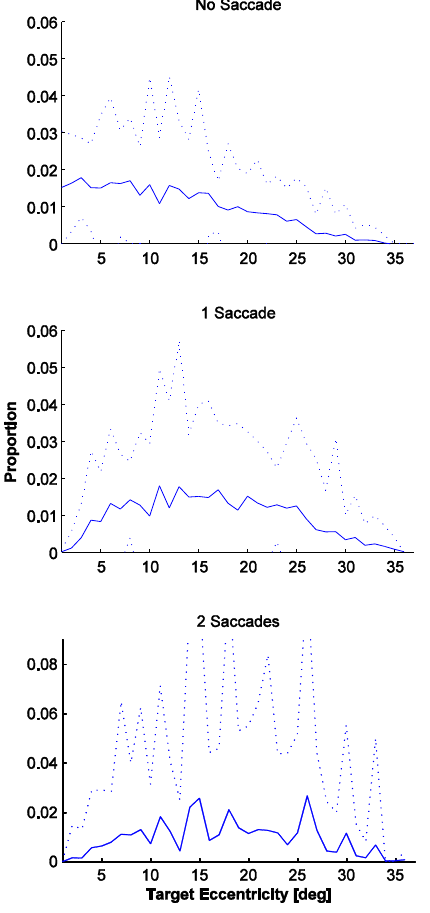
Figure 4. Distribution of target eccentricities for identification selections for which 0, 1 and 2 saccades toward the target were made, averaged across cueing conditions (cued/uncued; 0%, 25%, …, 100%). Top: 0 saccade (no-saccade selections). Middle: 1 Saccade. Bottom: 2 Saccades. Dotted = standard error of inter-observer